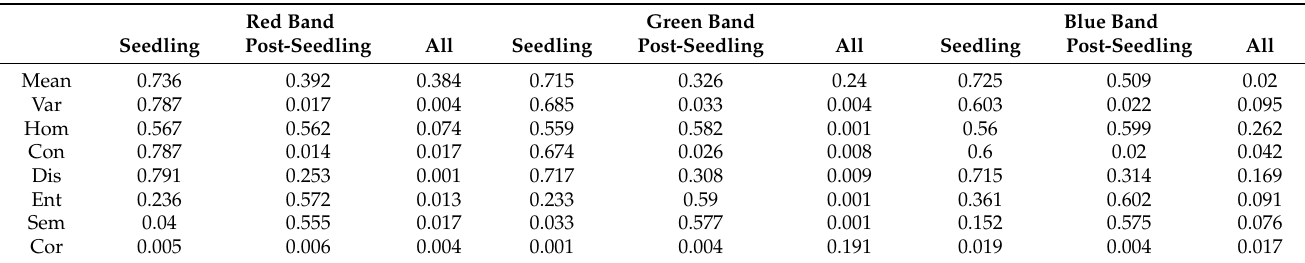
Table 5. Relationships between aboveground biomass and grey level co-occurrence matrix-based texture measurements with the calibration set (R 2